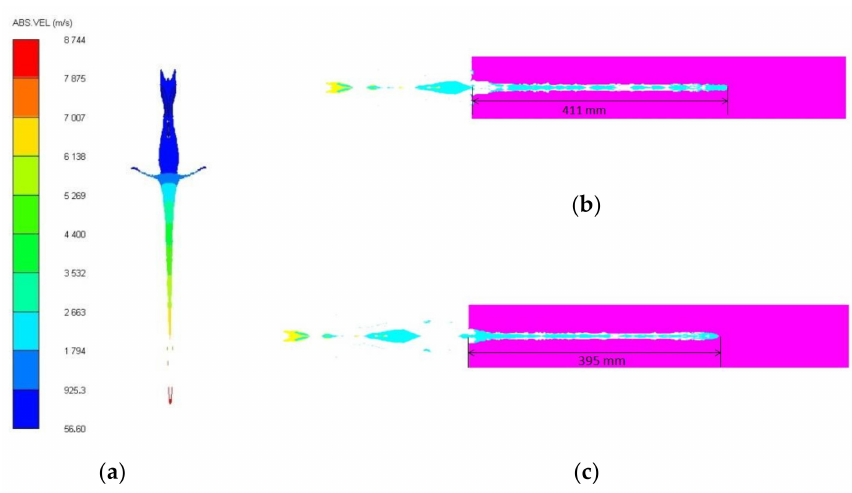
Figure 9. The velocity distribution of projectile and penetration depth. ( a ) The shape and velocity distribution of projectile at 50 µ s; ( b ) penetration depth at the standoff distance of 2.0 D; ( c ) penetration depth at the standoff distance of 2.5